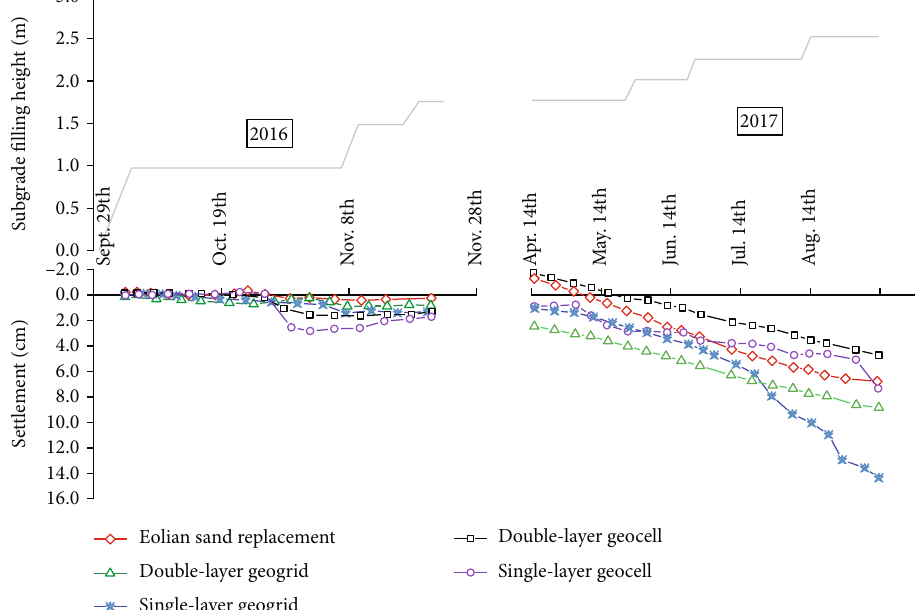
Figure 5: Subgrade middle subsidence-time change